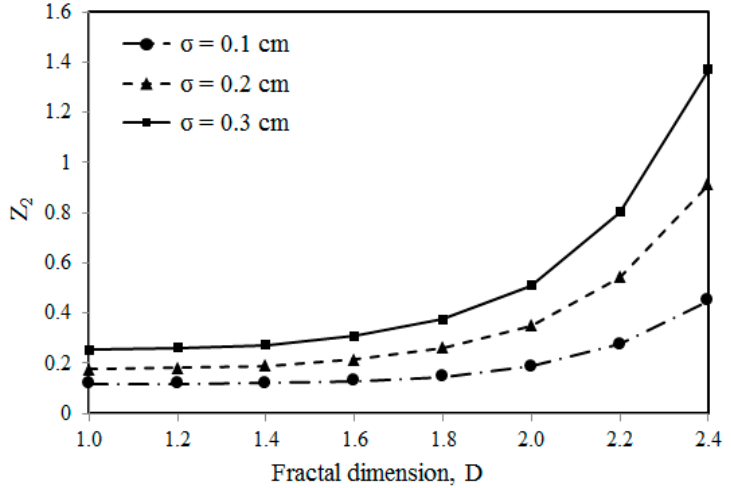
Figure 10. Relationship between Z 2 , fractal dimension and standard